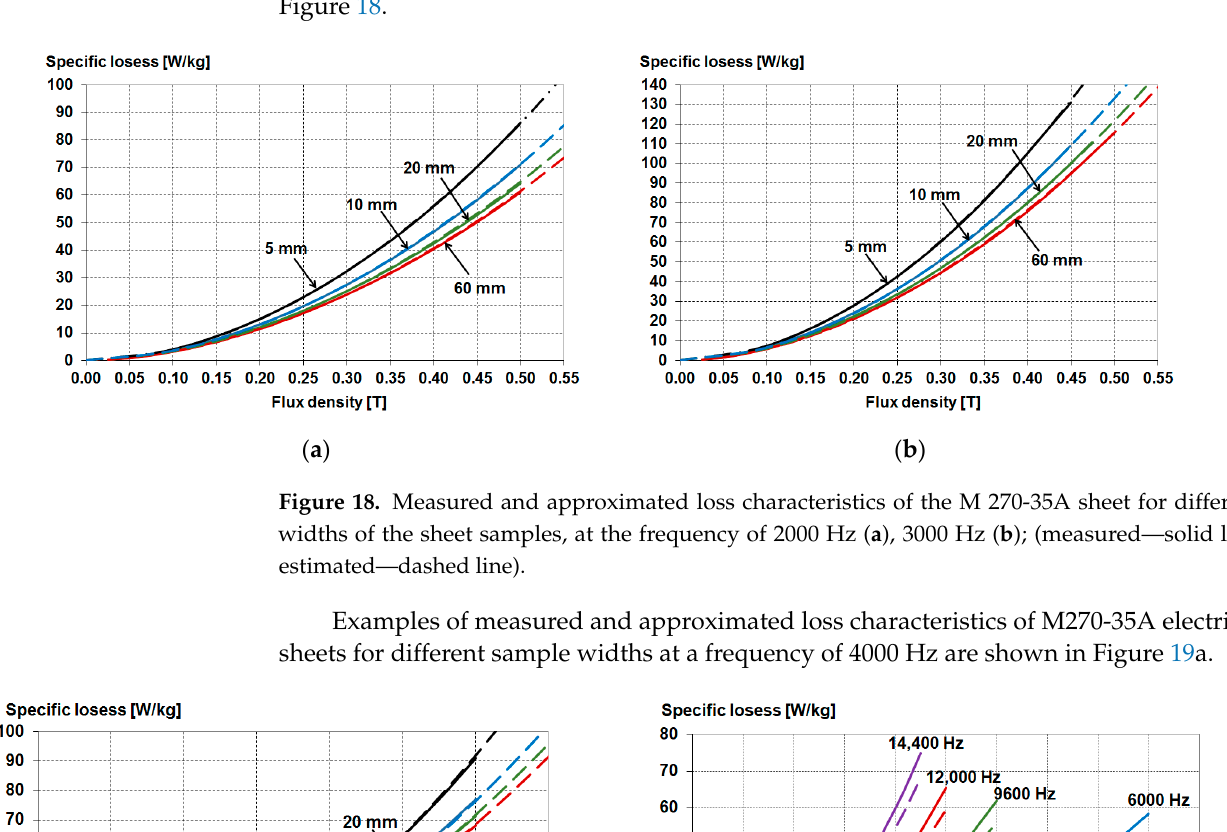
Figure 17. Measured and approximated loss characteristics of the M 270-35A sheet for different widths of the sheet samples, at the frequency of 1000 Hz ( a ), 1400 Hz ( b ); (measured—solid line, estimated—dashed line).